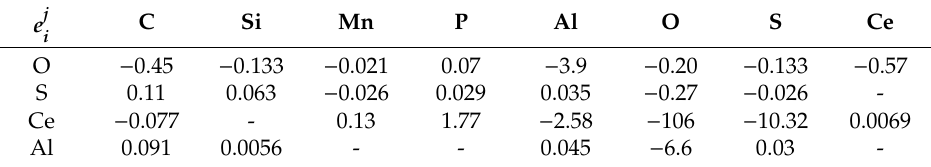
Table 3. Interaction coe ffi cients of elements in the SWRS82B steel at 1873 K